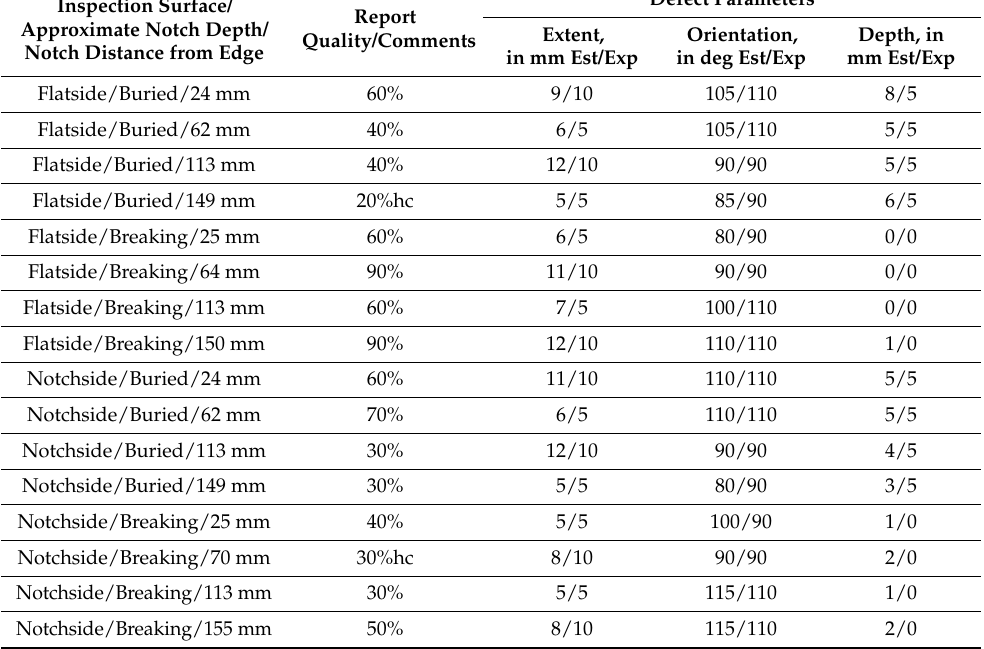
Table 1. The DPS data set: Estimated (est) and experimental (exp) crack characteristics. The crack position is specified as distance between the notch and left edge of the specimen. The “hc” stands for Human Choice and indicates that the estimates are chosen by a human and not the AI. Inspection Surface/ Approximate Notch